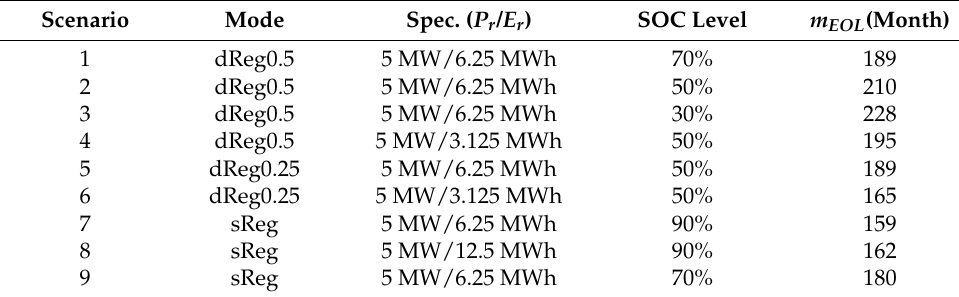
Table 4. Battery life overview for each scenario.